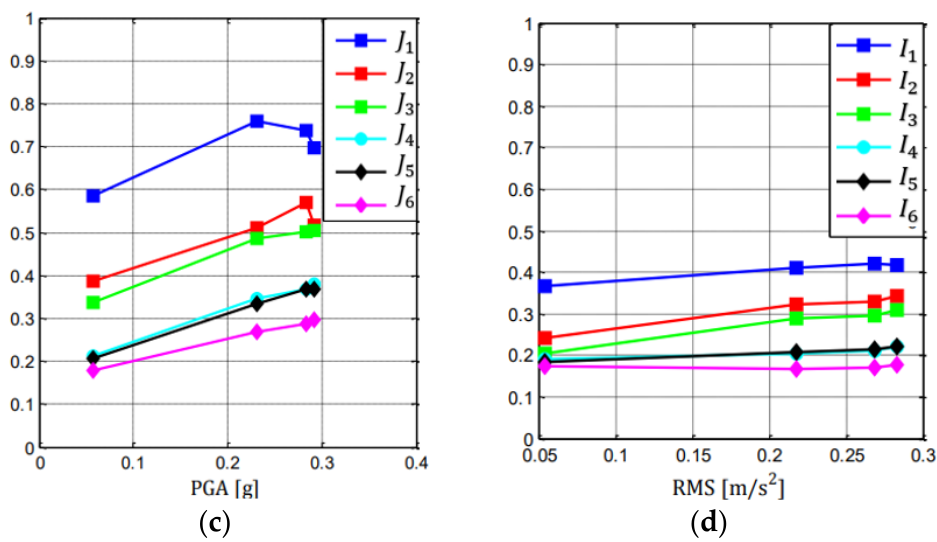
Figure 15. NE — response indices based on maximum values ( 𝐽 𝑛 ) and RMS values ( 𝐼 𝑛 ), n = 1 – 6, varying the input intensity for near-fault earthquakes: ( a , b ) Kobe, ( c , d ) Northridge.